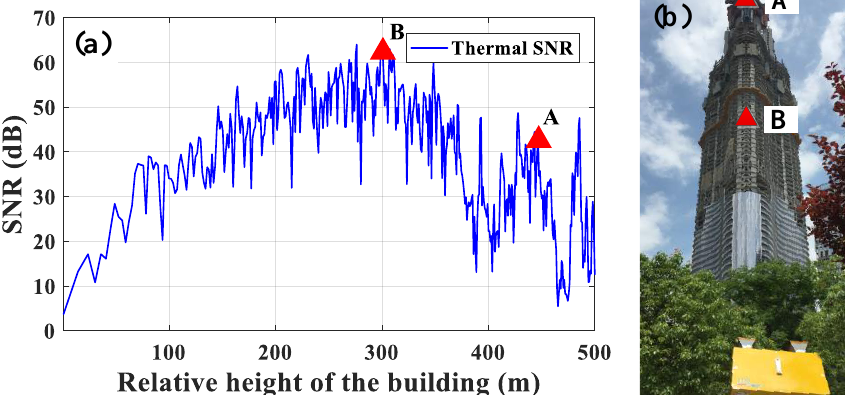
Figure 7. (a) Power profile of the WGC obtained from working base point S1 and selection of monitoring points. The red triangle denotes the monitoring point. The relative height of the building in the left figure is relative to working base point S1. Point A in the right figure is at the top of the building, with a height of 447 m relative to working base point S2. Point B is 300 m high relative to working base point S2. (b) Ground view of the WGC from the location of the IBIS-S-2 system.